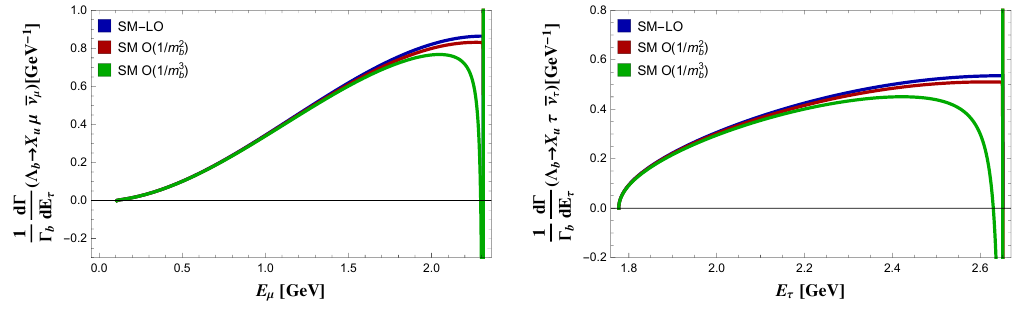
Figure 8 . Charged lepton energy spectrum in SM for (cid:3) b ! X u ‘ (cid:22) (cid:23) ‘ , with ‘ = (cid:22) (left) and ‘ = (cid:28) (right). The leading order result in the HQE is the blue line, the O (1 =m 2 the green line.